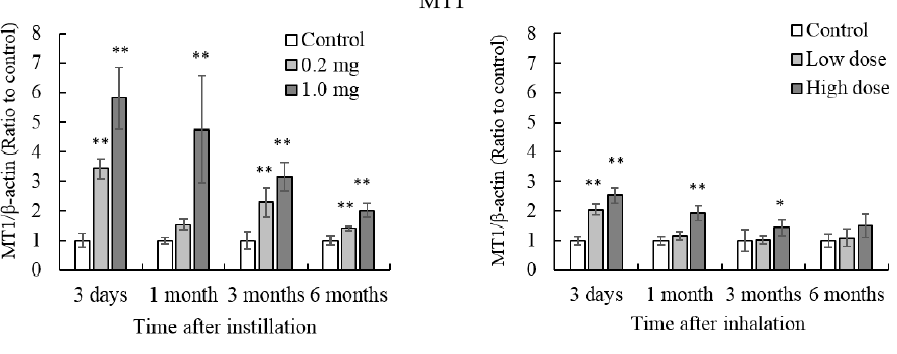
Figure 7. Cont. Figure 7.